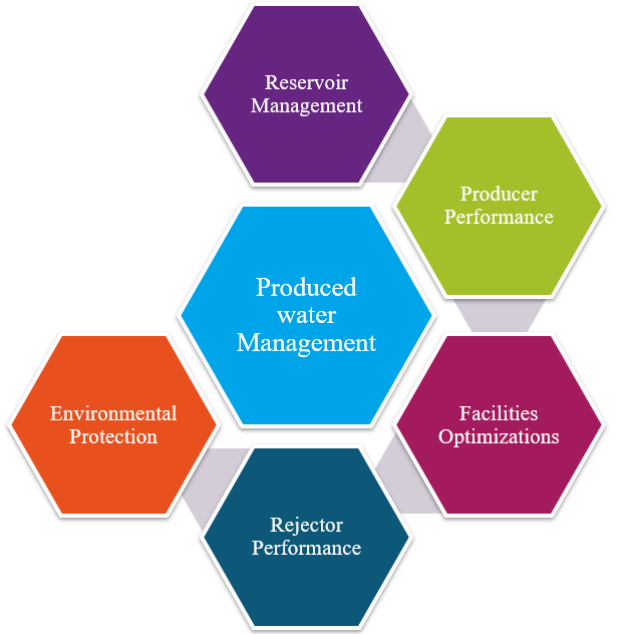
Figure 1. Produced water management [16].